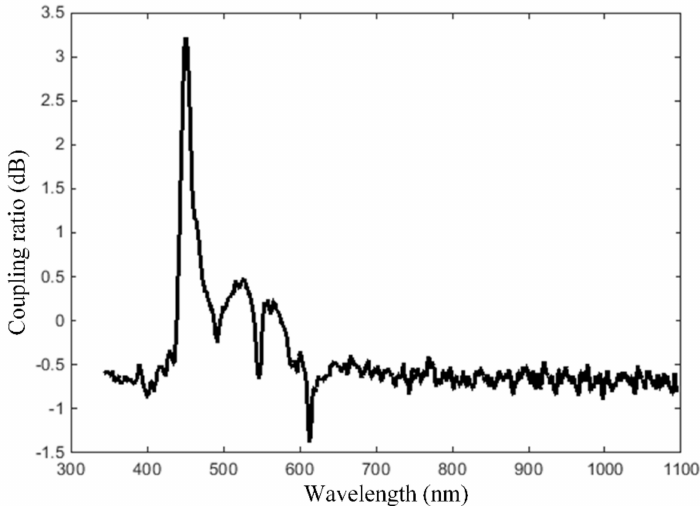
Figure 11. Wavelength dependent coupling loss of the extended sensing area intra-oral